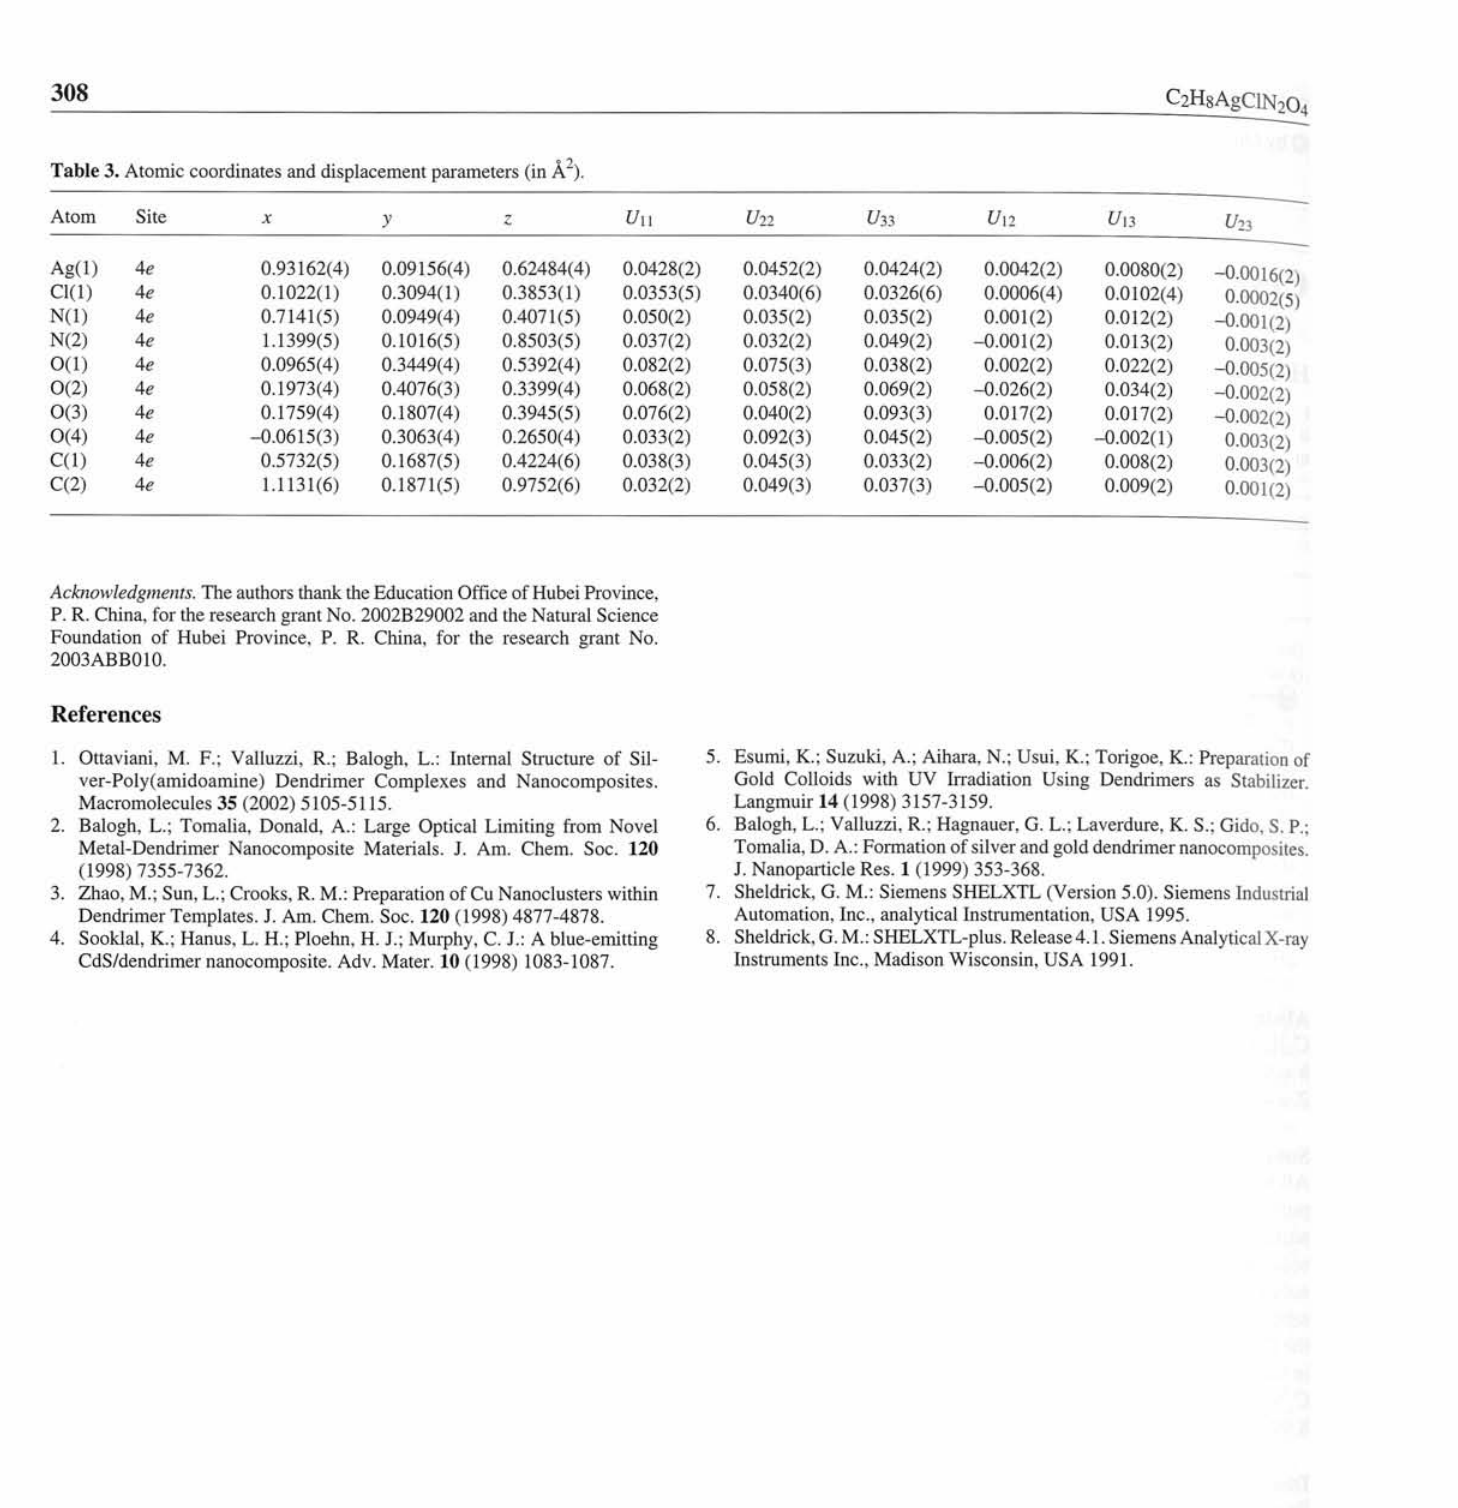
Table 3. Atomic coordinates and displacement parameters (in Á 2